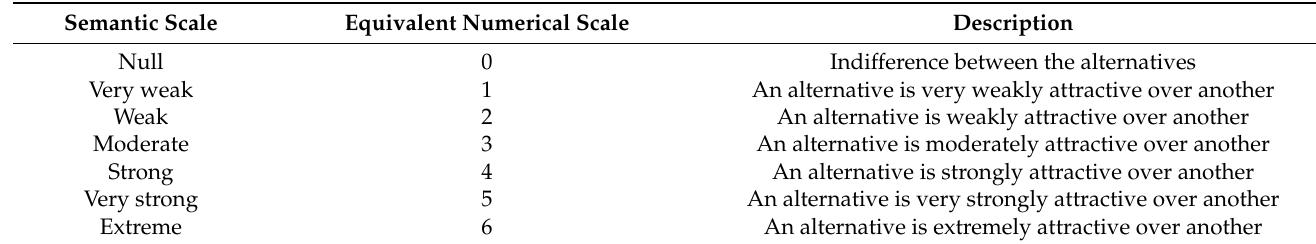
Table 2. MACBETH semantic scale.